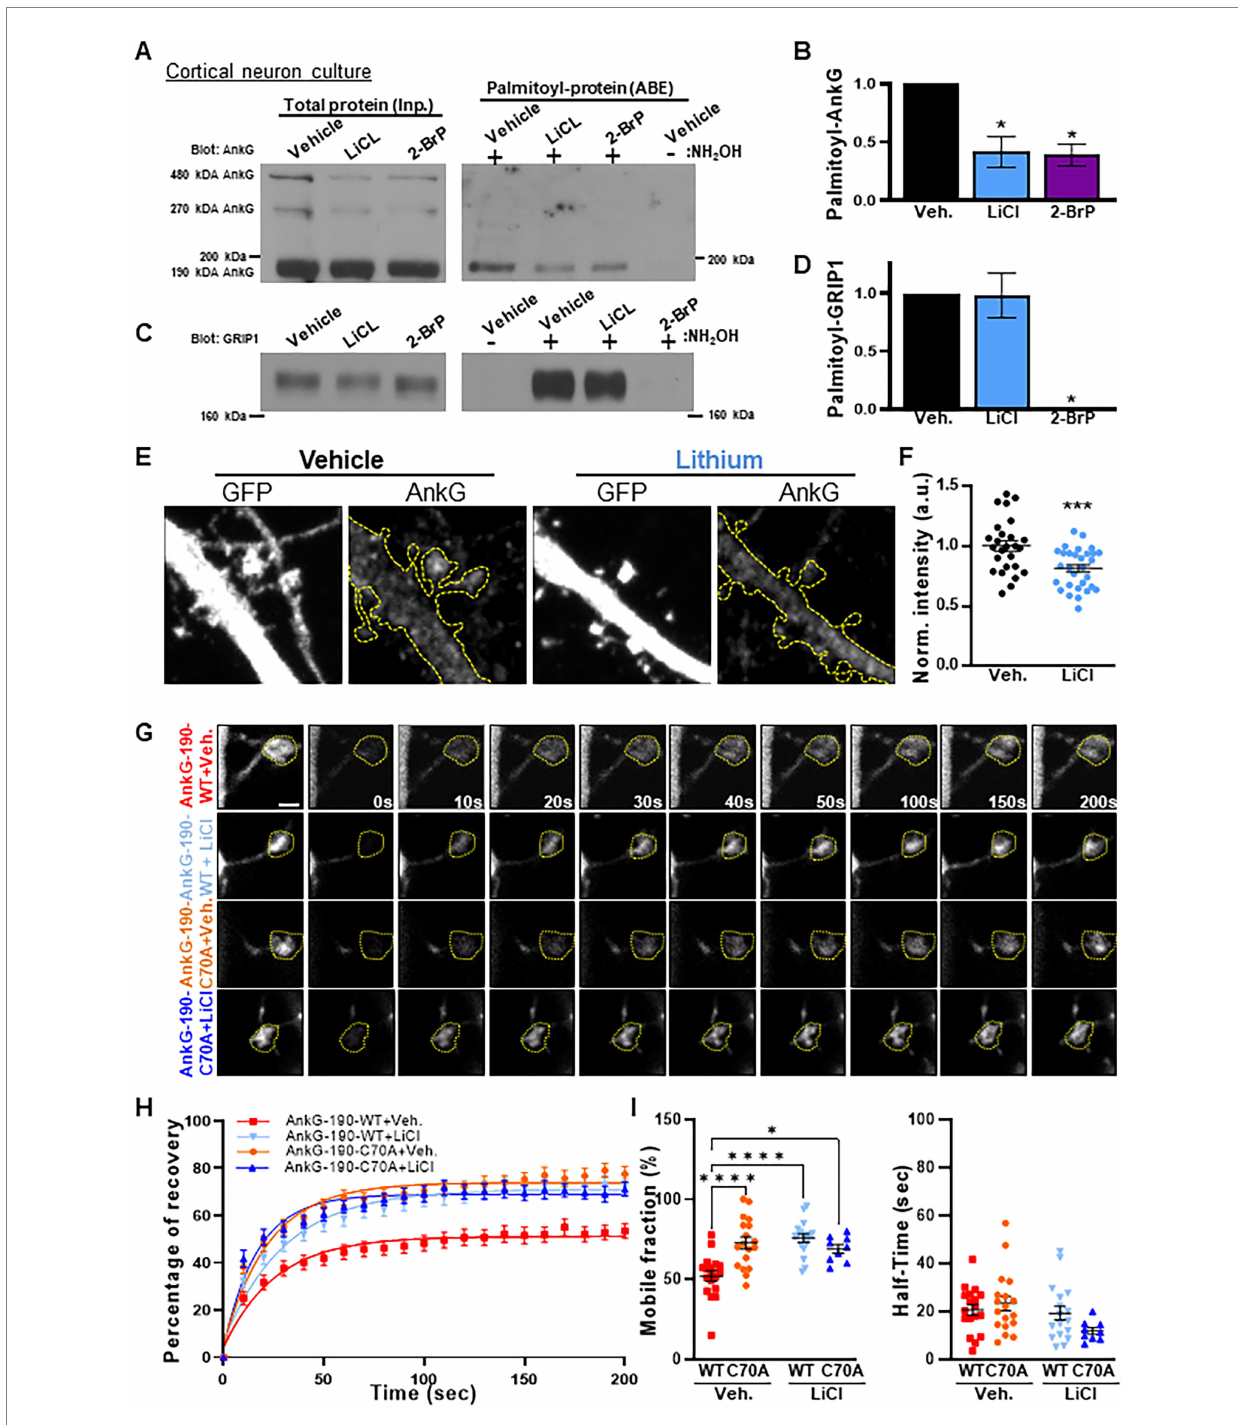
FIGURE 3 Lithium induces a decrease of palmitoylated AnkG-190 isoform and increases its mobility. (A) Lysates of cortical neurons treated with the indicated compounds were subjected to ABE to purify palmitoylated proteins. Levels of palmitoyl-AnkG-190 (right blot) and total AnkG expression in parent lysates (left blot bottom blot) were detected with specific antibodies. Exclusion of NH 2 OH was used as a control for assay specificity. (B) Bar graph of 190 kDa AnkG isoform palmitoylation normalized with the input and relative to the untreated condition (5 independent experiments, t -test, * p < 0.05, ±SEM). (C) Lysates of cortical neurons treated with the indicated compounds were subjected to ABE to purify palmitoylated proteins. Levels of palmitoyl-GRIP1 (right blot) and total AnkG expression in parent lysates (left blot) were detected with specific antibodies. Exclusion of NH 2 OH was used as a control for assay specificity. (D) Bar graph of GRIP1 palmitoylation normalized with the input and relative to the untreated condition (4 independent experiments, Kruskal–Wallis with Dunn’s post-test, * p < 0.05, ±SEM). (E) Representative maximal projection of a confocal image of endogenous AnkG staining in cortical neurons transfected with GFP with or without lithium stimulation, scale = 2 μ m. (F) Scatter plot of AnkG average intensity in mushroom spines on a single plane (26–30 neurons on 3 independent experiments, t -test, *** p < 0.001, ±SEM). (G) Representative time-lapse images of GFP- AnkG-190 fluorescence in 24 days rat neurons culture overexpressing GFP-AnkG-190-WT or GFP-AnkG-190-C70A for 3 days +/ − lithium chloride during 1 day in FRAP experiments, scale = 2 μ m. (H) Quantification of GFP fluorescence in spines over time. Data are fitted with single exponentials (colored lines). Data are represented as mean ± SEM. (I) Scatter plots of mobile fraction (left) or half-time recovery (right) of GFP-AnkG-190-WT or GFP- AnkG-190-C70A +/ − lithium chloride ( n = 9–18 neurons, two-way ANOVA with Tukey post-test, **** p ≤ 0.0001, * p < 0.05,